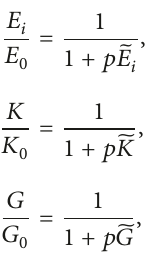
where MID is a midrange value, 𝑆 𝑉 is surface area-to-volume ratio, and V is Poisson’s ratio. The dimensionless parameters ̃𝐸 , ̃𝐾, ̃𝐺 ) of the 4-factor PCC model are the influential degree ( 𝑖 of micropores as